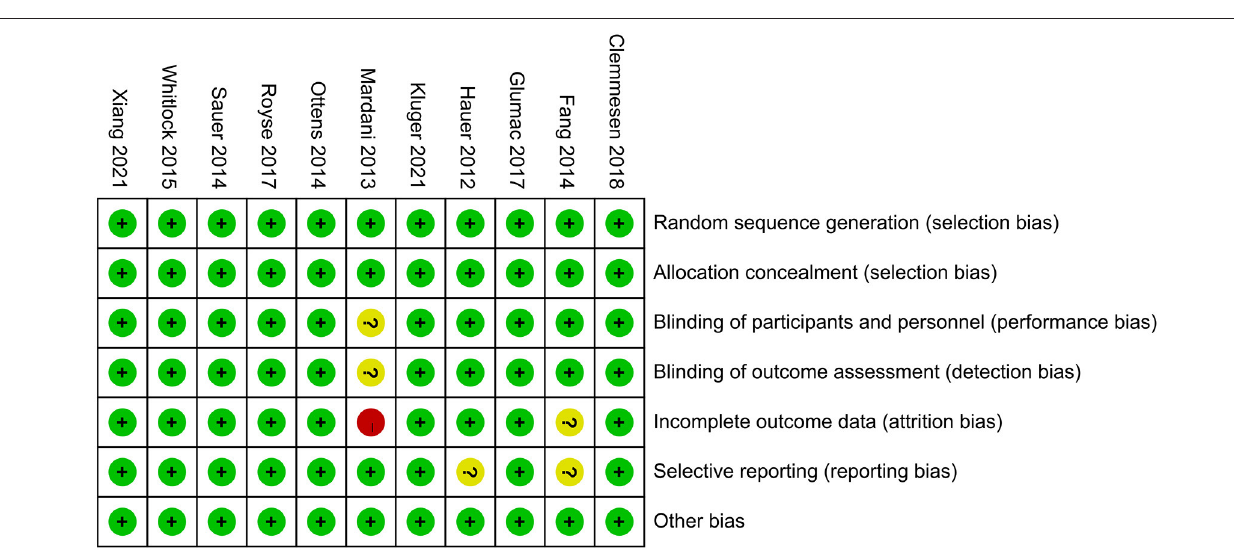
FIGURE 2 | Risk of bias assessment was undertaken for each included trial according to the Cochrane Risk of Bias